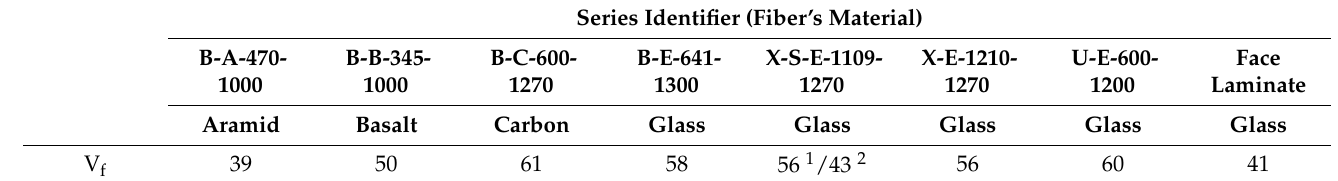
Table 7. Fiber volume fraction (V f ).